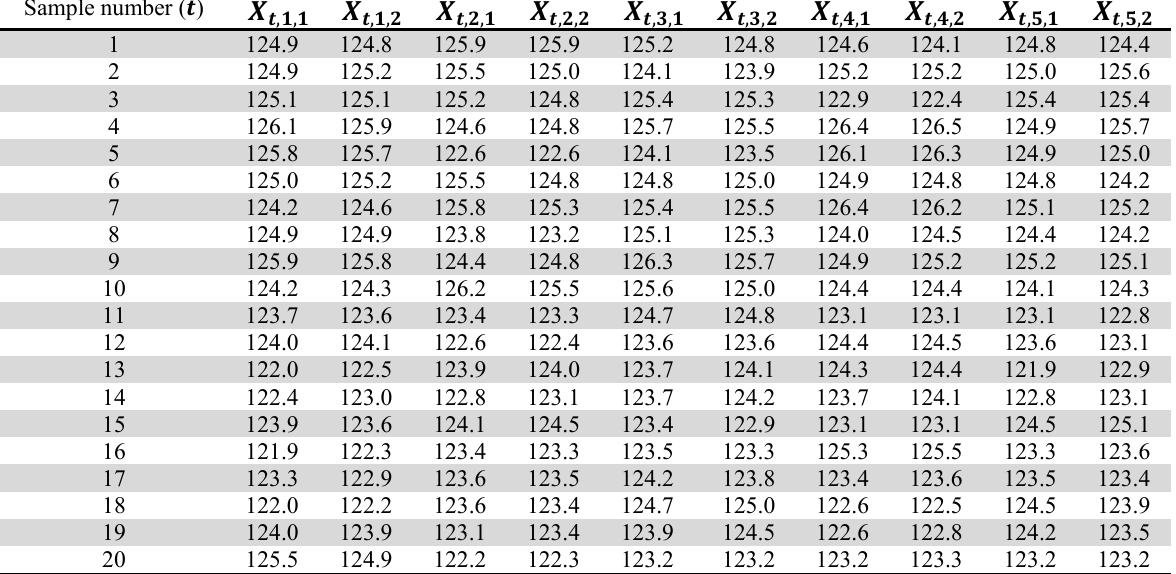
and the R&R historical study indicates that 𝜎 Table 8 The weight of the yogurt filling cup process dataset